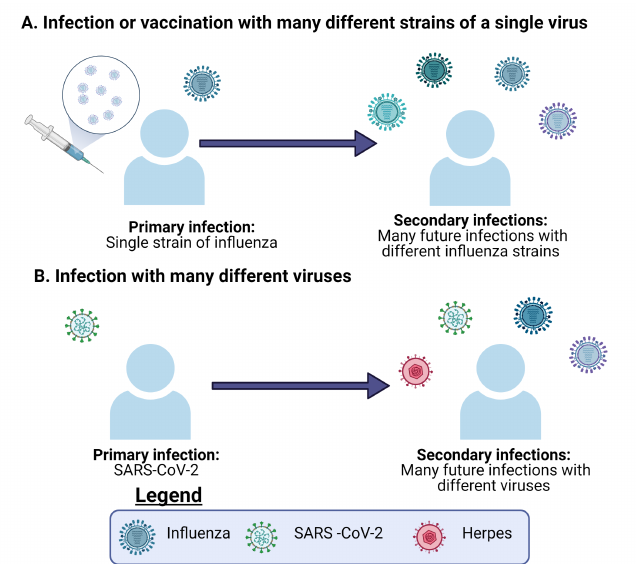
Figure 2. The definitions of heterologous infection and heterologous immunity. ( A ) An individual infected with several heterologous influenza viruses. ( B ) An individual infected with different viruses. In both ( A , B ), the primary infection or vaccination serves to generate immunity, which is then considered pre-existing when the individual is later infected with different